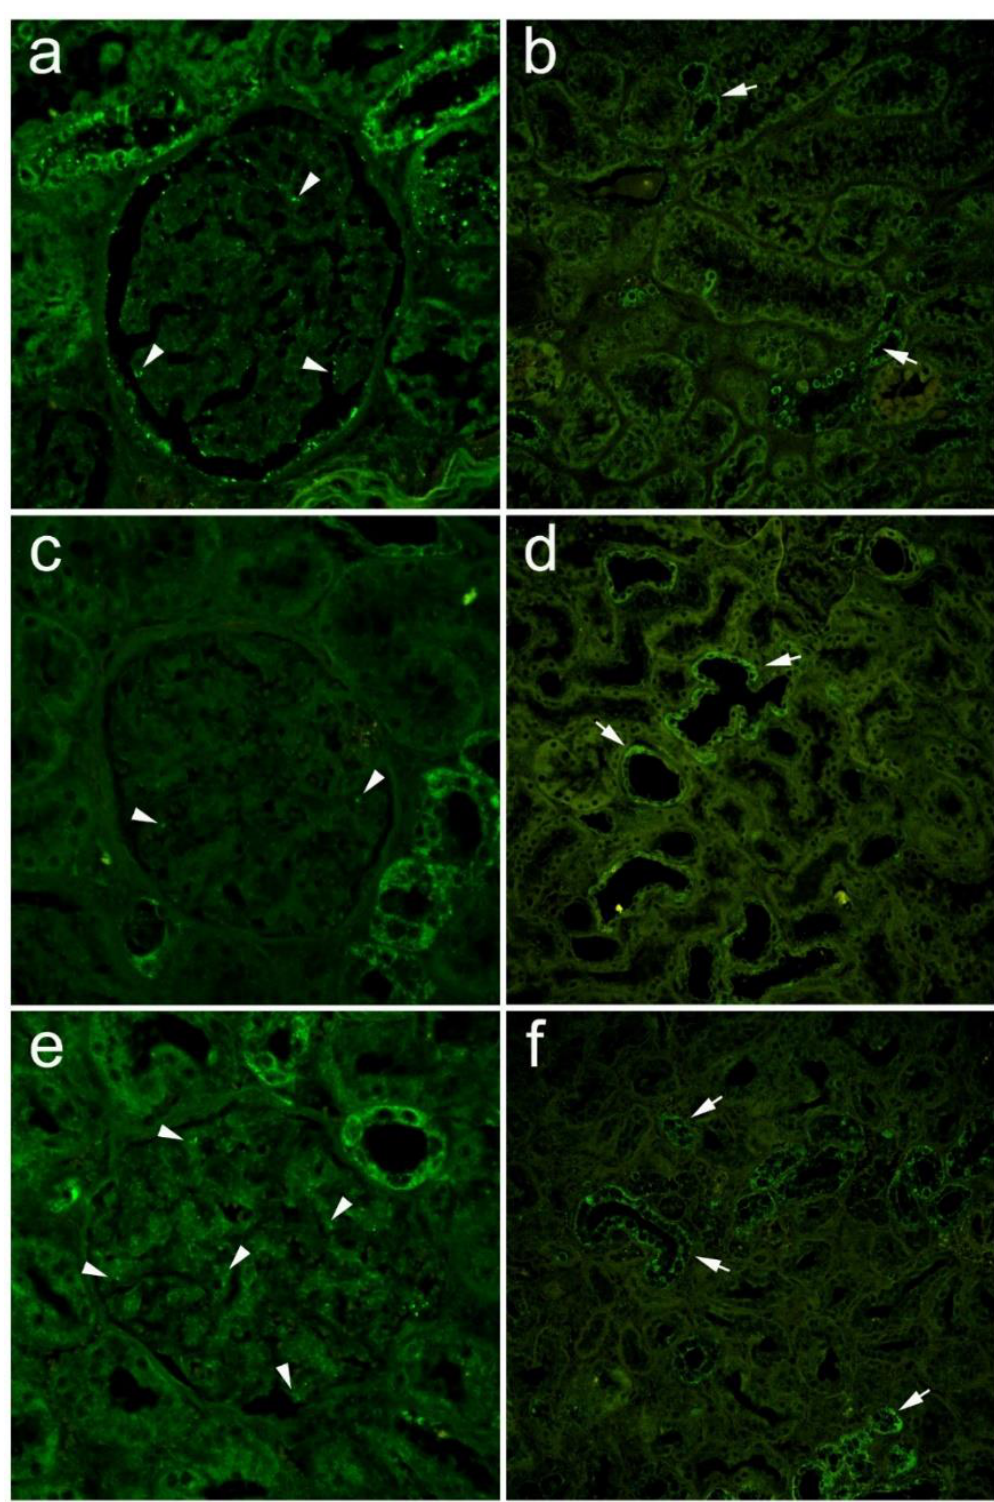
Figure 6. Expression of pannexin 1 in glomeruli and tubules of nondiabetic and diabetic patients. Re- nal sections were stained immunohistochemically by using anti-Panx1 antibody (green). ( a ) Glomeru- lus of nondiabetic patient with normal creatinine; ( b ) tubuli of the same patient; ( c ) glomerulus of diabetic patient with normal creatinine; ( d ) tubuli of the same patient; ( e ) glomerulus of diabetic patient with elevated creatinine; ( f ) tubuli of the same patient. Arrowheads—Panx1 expression in glomeruli; arrows—Panx1 expression in